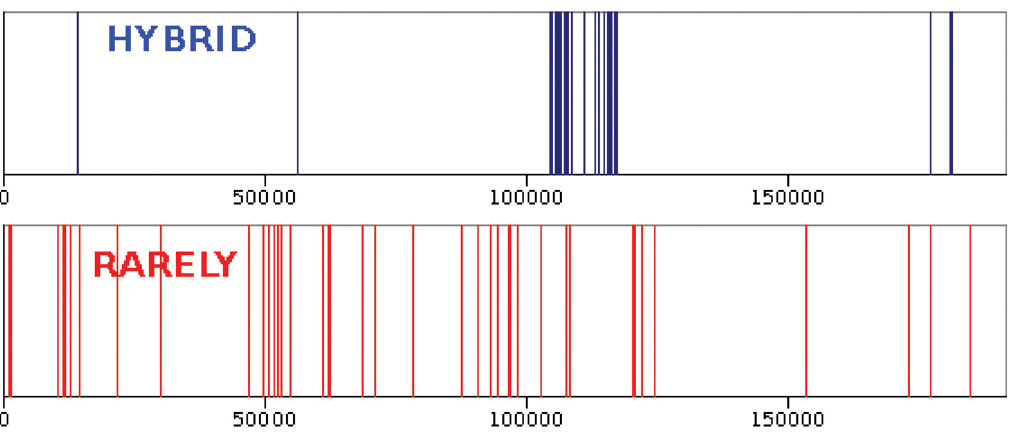
Fig 5. Spatial distribution of two words, HYBRID and RARELY, in the book, The Origin of Species . According to subject of the book, HYBRID is an important and the RARELY is an irrelevant word, both of them have the same frequency equal to 45. RARELY is distributed in the text, uniformly but, HYBRID is clustered.